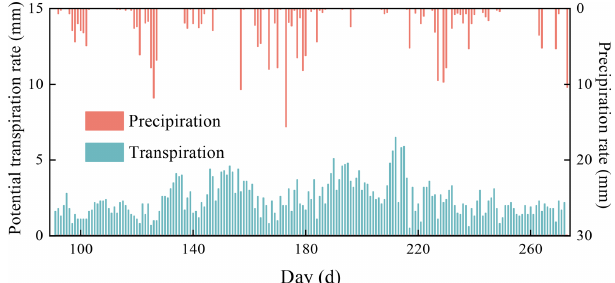
Figure 3. The values of actual precipitation and potential transpira- tion rates of case